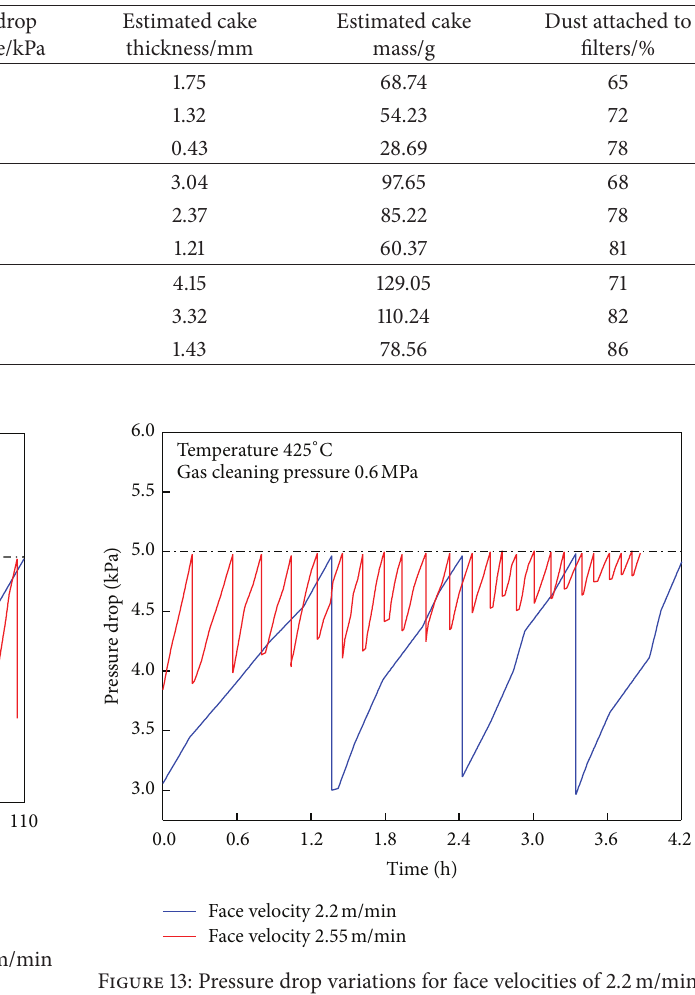
Table 4: Dust cake thicknesses estimated and pressure drop across the cake.